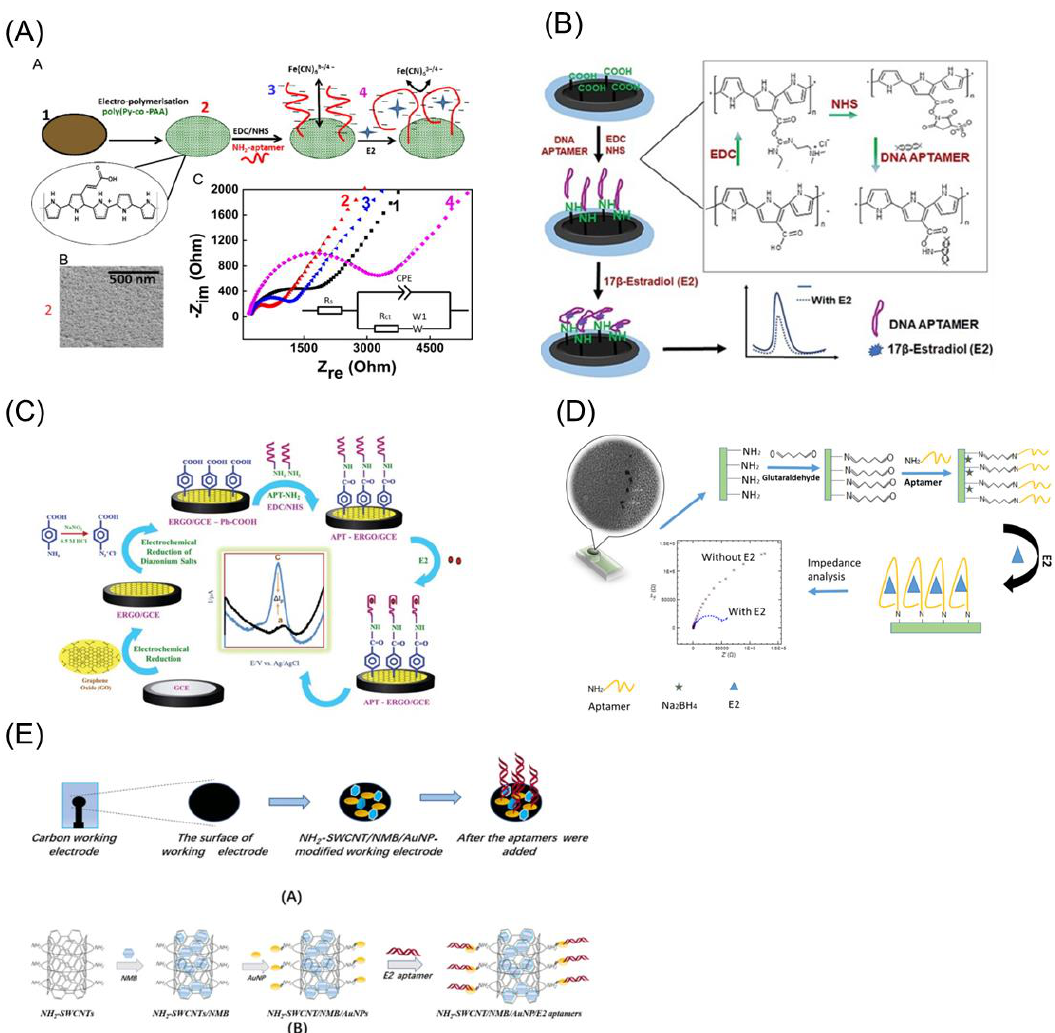
Figure 10. Electrochemical aptasensors based on carbon-based electrode platforms for E2 detection. The carbon-based aptasensor electrode platforms are the ( A ) glassy carbon/pyrrole (Py) and 3-pyrroleacrylic acid (PAA) (poly(Py-co-PAA)–aptamer electrodes. Reprinted with permission